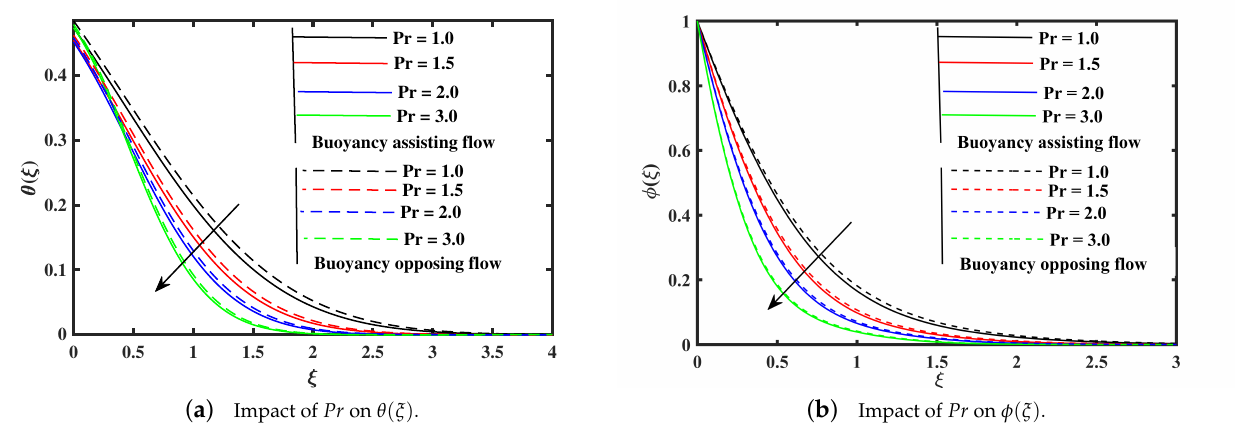
Figure 7. Fluctuation of θ ( ξ ) and φ ( ξ ) against Prandtl number ( Pr